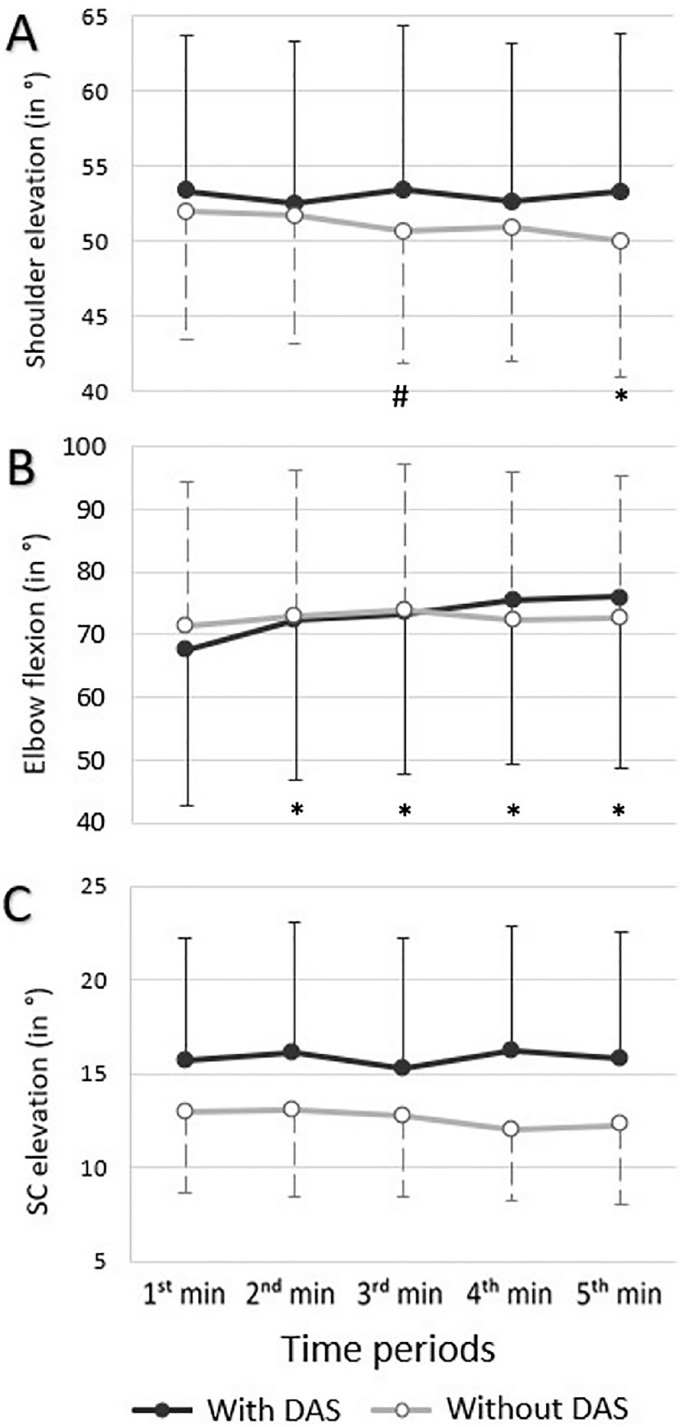
Fig 5. Mean joint position (in degrees; with standard deviation) during the static task in A) shoulder elevation, B) elbow flexion, and C) sternoclavicular (SC) elevation with and without the dynamic arm support (3D-DAS) (n = 15). Significantly different (P < 0.05/7 or < 0.007 [Bonferroni adjustment]) compared to � the 1 st minute and # the previous minute when the task was performed without the 3D-DAS for shoulder elevation and when the task was performed with the 3D-DAS for elbow